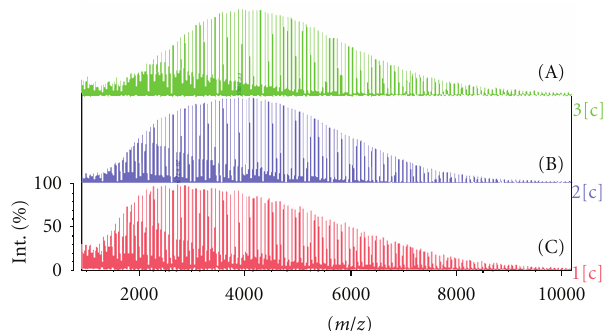
Figure 7: MALDI-TOF spectra of initial PLA (A) and PLA + Sn(Oct) 2 refluxed with (B) and without (C) of α